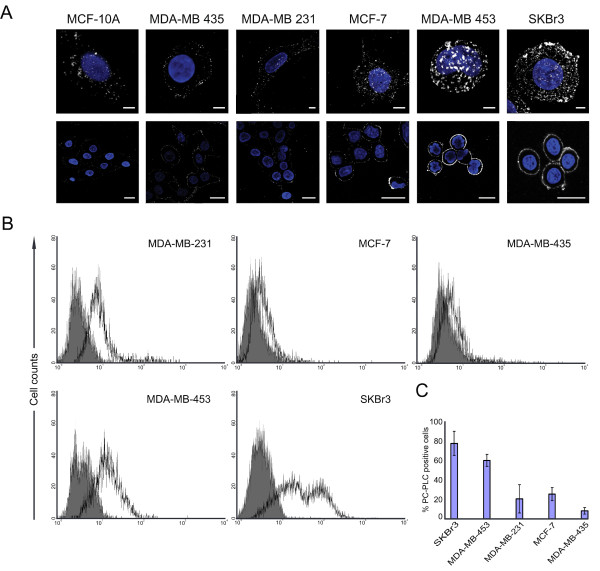
PC-PLC expression on plasma membrane of breast cancer cells. (a) CLSM analyses of six unfixed cell lines stained for PC-PLC detection (pseudo-color grey). Upper panels show examples of a three-dimensional reconstruction of a single cell (scale bars, 5 μm); the lower panels show single central sections of a group of cells (scale bars, 20 μm). Nuclei were stained with DAPI (blue). (b, c) FACS analyses of unfixed cells: representative cytofluorimetric histograms of PC-PLC relative fluorescence intensity of the indicated cell lines (b) and percentage (mean ± SD) of PC-PLC positive cells (c). Statistical significance of differences between HER2-overexpressing (SKBr3 and MDA-MB-453) and HER2-non-overexpressing (MDA-MB-231, MCF-7, MDA-MB-435) carcinoma cell lines was P < 0.001. Five independent experiments were performed on each cell line.